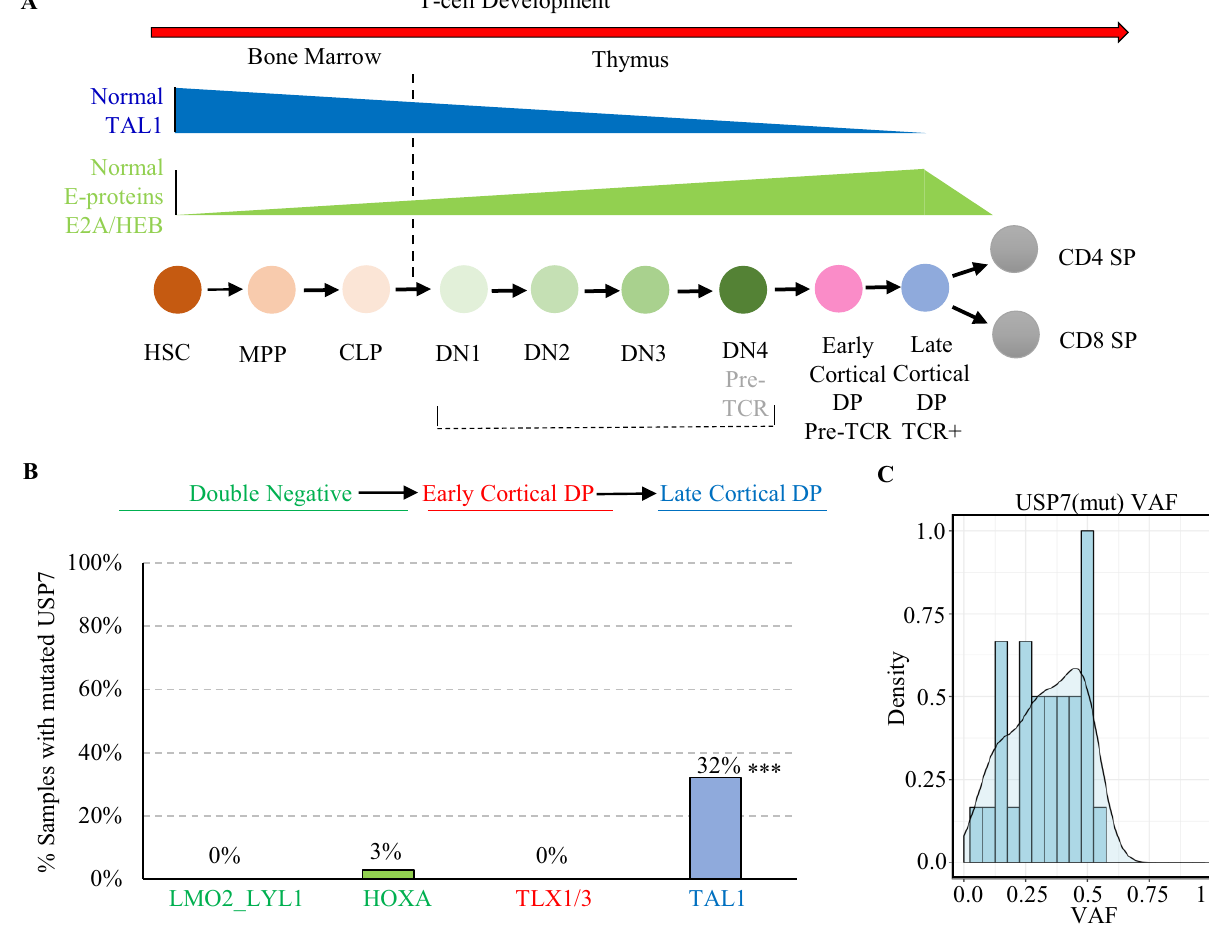
Figure 1. USP7 haploinsufficiency is enriched in the TAL1-activated T-ALL. ( A ) TAL1 and E-protein activities at different stages of normal hematopoiesis adapted from Sanda and Leong 55 . TAL1 is active during the early stage of T-cell development but down-regulated throughout T-cell maturation. E-protein, which is negatively regulated by TAL1, shows an opposite pattern. The blue color shows the decreasing TAL1 activity in normal hematopoiesis development. The green color shows E-protein activity in normal hematopoiesis development. ( B ) Prevalence of USP7 mutations in the four major T-ALL subgroups with ≥ 5% incidence in the TARGET T-ALL cohort. All but one of the USP7 mutations are in the TAL1 subgroup, and the enrichment is statistically significant (***p-value = 1.1e−11 by a two-sided Fishers-exact test). Representative T-ALL subgroups are ordered by their T-cell development state. ( C ) Density plot of the variant allele frequency (VAF) distribution of USP7 somatic